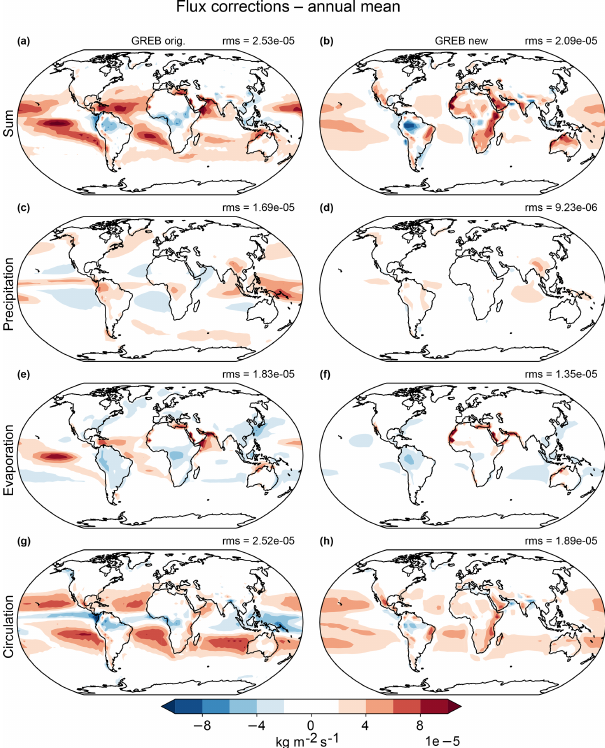
Figure 5. Annual mean precipitation for four development steps of the GREB precipitation parameterisation (a, c, e, g) and their cor- responding seasonal cycles (b, d, f, h) in mmday − 1 . The first step was changing the specific humidity boundary climatology (a, b) . Then subsequently more variables have been added to the precipita- tion parameterisation: adding only relative humidity (c, d) , adding only ω (e, f) , adding relative humidity and ω (g, h) .